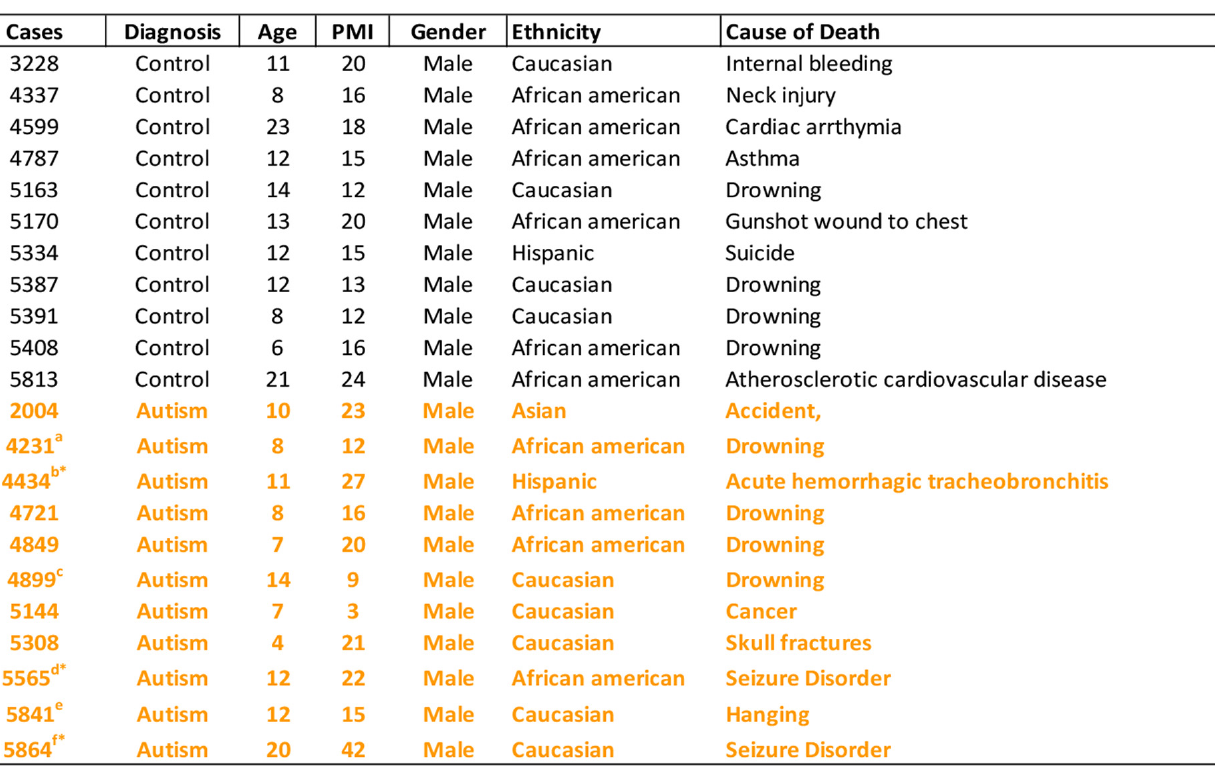
TABLE 1 | Postmortem brain donor case